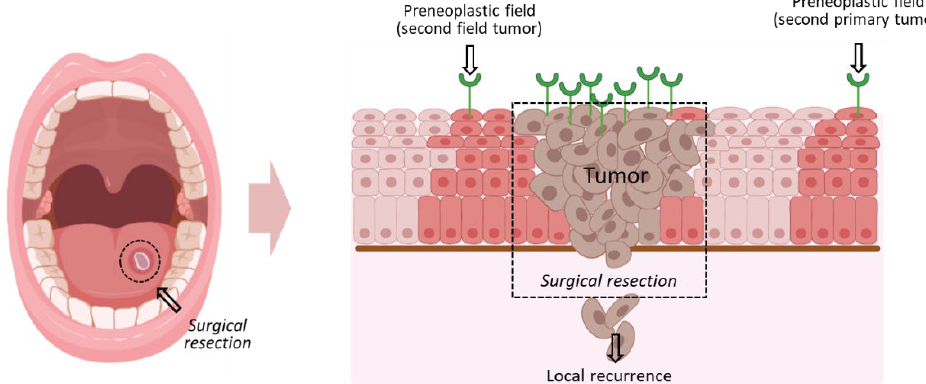
Figure 1. HNC lesion cell and GB3 receptor distribution in precancerous and malignant HNC cells. Diagram of the relationship between clinically identifiable HNC lesion (circled) and clinically invisible precursor fields of cancerous tissue (in red). The surrounding preneoplastic cells are the source of local recurrences (which develop from the primary tumor) and second primary tumors (from a second field) after surgical resection of the initial carcinoma. These areas are indicated in the diagram. The expected expression of the GB3 receptor (in green) in these regions is shown. Created with BioRender.com.